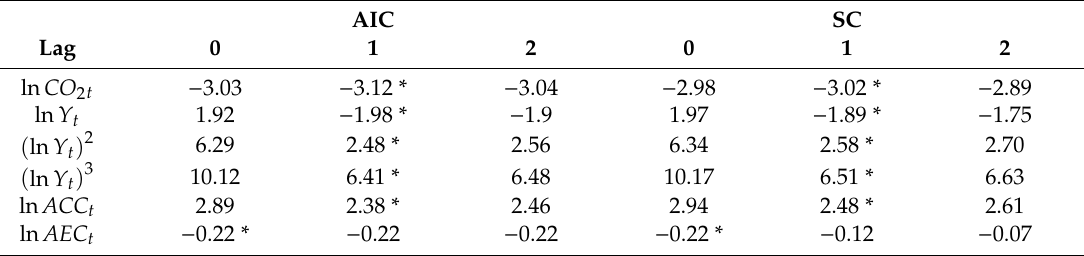
Table 5. Lag selection